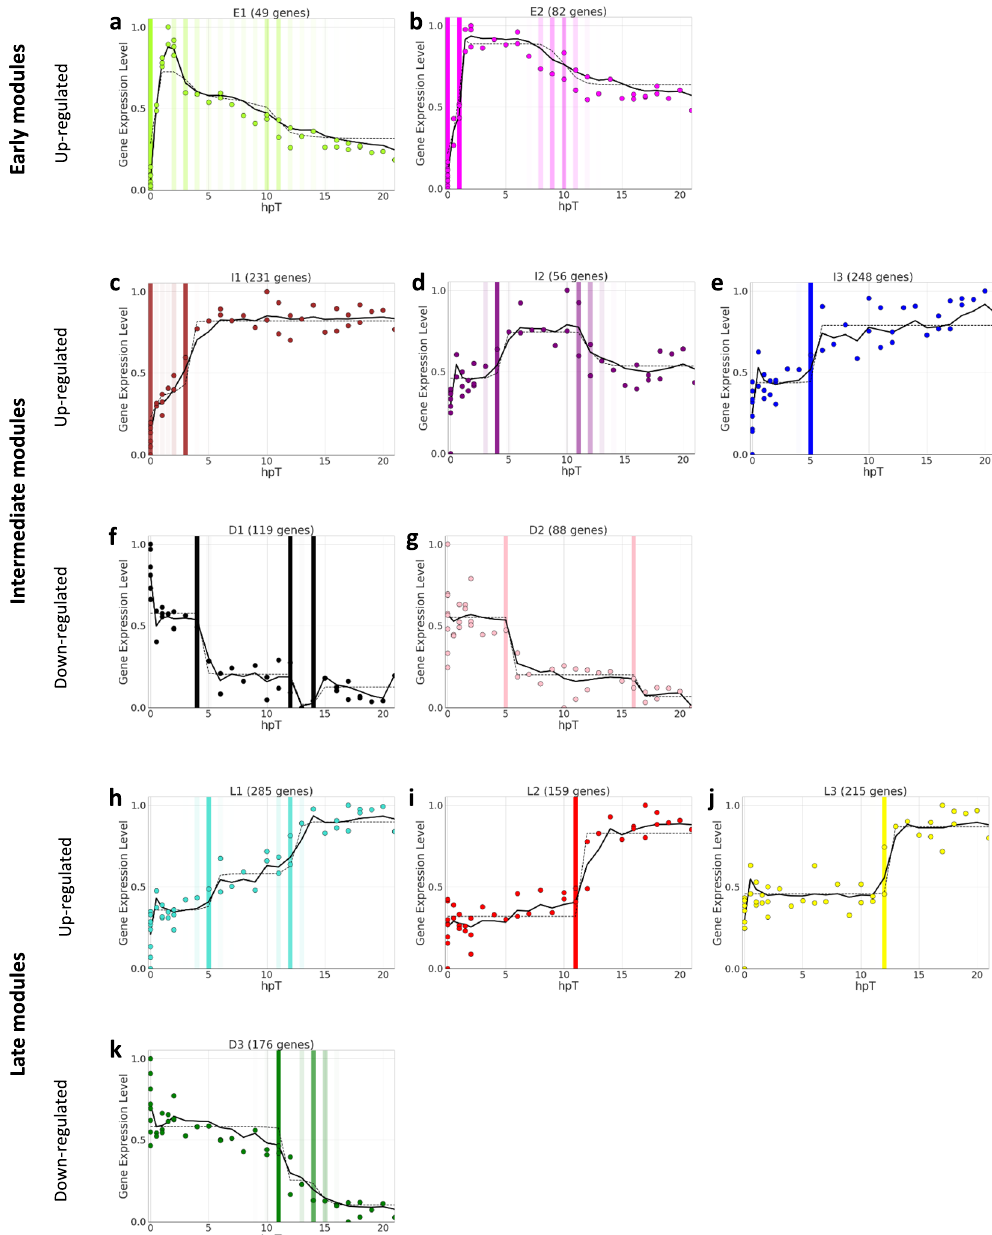
Fig. 2 Co-expression modules deployed in response to spinal cord injury. WGCNA analysis clustered genes in 11 co-expression modules. The graphs show the adjusted kinetic pro fi le for each module. Colored dots represent the eigengene modules, continuous lines indicate a regime-switching model used to explore possible change points, discontinuous lines show a change-point model for each module, and vertical color bars highlight temporal points at which we observe a change in the direction of gene expression, with more intense bars indicating a higher probability of change. a , b Early upregulated modules E1 and E2; c – e intermediate upregulated modules I1, I2, and I3; f , g intermediate downregulated modules D1 and D2; and ( h – k ) late upregulated L1, L2, and L3 and downregulated module morphological organization of neural progenitor cells in the protein binding, peptide transporter activity, cytoplasmic ribonu- central canal of spinal cord (Fig. 3). Furthermore, genes linked to cleoprotein granule, endoplasmic reticulum chaperone complex, neurogenesis, such as nestin and components of the WNT protein processing in endoplasmic reticulum, N-glycan biosynth- pathway (wnt7b, fzd2, fzd3, and ctnnb1), were found as well. esis, and protein export from nucleus. These results, together with the activation of important RBFs The GO terms and KEGG pathways DNA replication initiation, involved in stem cell homeostasis and self-renewal, suggest that DNA replication origin binding, MCM complex, cell cycle, stem cell activation of NSPC is a key process in spinal cord regeneration. division, and proliferation and signaling pathways regulating An enrichment of the biological process related to lymphocyte pluripotency of stem cells were enriched in modules L2 and L3 and T cell proliferation is observed in module D3, with a signi fi cant (Fig. 3 and Supplementary Tables S3 – S6). Of note, in module L2, a reduction of RNA levels starting at 11 hpT (Fig. 3 and concomitant enrichment in genes linked to columnar/cuboidal Supplementary Table S4). Among the genes included in these epithelial cell development was found, which correspond to the